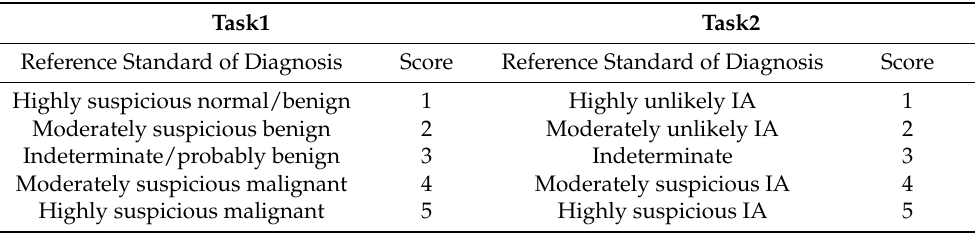
Table 2. The reference standards of imaging diagnosis for two tasks. To score the malignancy risk and invasive risk of each GGN, two diagnostic reference standards were developed by grading the risk with five